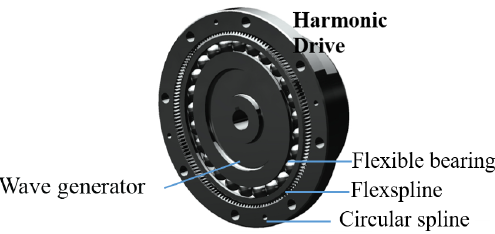
Figure 1. Structures of harmonic